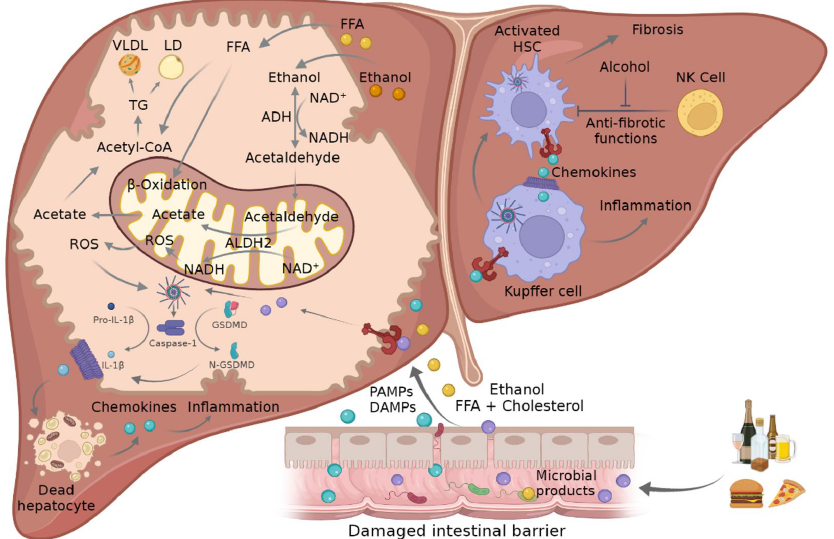
Figure 2. Mechanism of crosstalk between mitochondria and inflammasome in ASH and NASH. Ethanol consumption and FFA- and cholesterol-enriched diets can lead to damaged intestinal barrier where PAMPs and DAMPs such as FFA or microbial products go through the disrupted tight junctions and promote NLRP3 inflammasome activation in liver cells. This triggers the activation of caspase-1, which mediates the cleavage of pro-IL-1 β and GSDMD into their mature forms, which in turn promote hepatocellular death and the attraction and activation of KCs and HSCs, leading to inflammation and fibrosis. The metabolism of ethanol and FFA in hepatocytes induces an increment in ROS in the mitochondria that in turn triggers inflammasome activation. ADH, alcohol dehydrogenase; ALDH2, acetaldehyde dehydrogenase 2; ASC, adaptor apoptosis speck protein; DAMPS, damage- associated molecular patterns; FFA, free fatty acid; GSDMD, gasdermin D; HSC, hepatic stellate cells; IL-1 β , interleukin-1 β ; KC, Kupffer cells; NADH/NAD + , oxidized and reduced nicotinamide adenine dinucleotide ratio; NLRP3, NLR family pyrin domain containing 3; NK, natural killer cells; PAMPs, pathogen-associated molecular patterns; ROS, reactive oxygen species; TCA, tricarboxylic acid